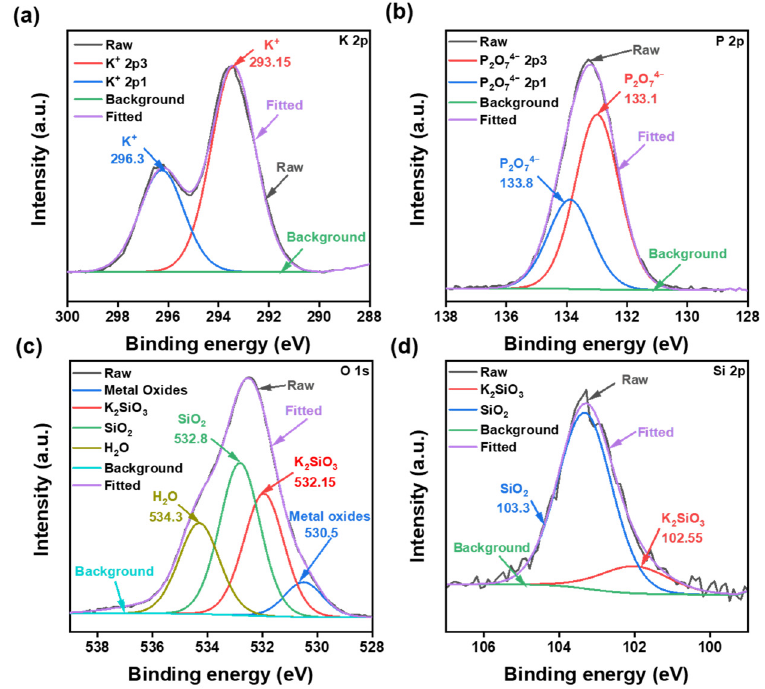
Figure 8. XPS fine spectra of quartz glass after immersion test. ( a ) K 2p, containing two peaks near 296.3 and 293.15 for K + ; ( b ) P 2p, containing two peaks near 133.1 and 133.8 for P 2 O 74 − ; ( c ) O 1s, containing four peaks near 532.8 for SiO 2 , 532.15 for K 2 SiO 3 , 534.3 for H 2 O and 530.5 for Metal oxides; ( d ) Si 2p, containing two peaks of 103.3 for SiO 2 and 102.55 for K 2 SiO 3